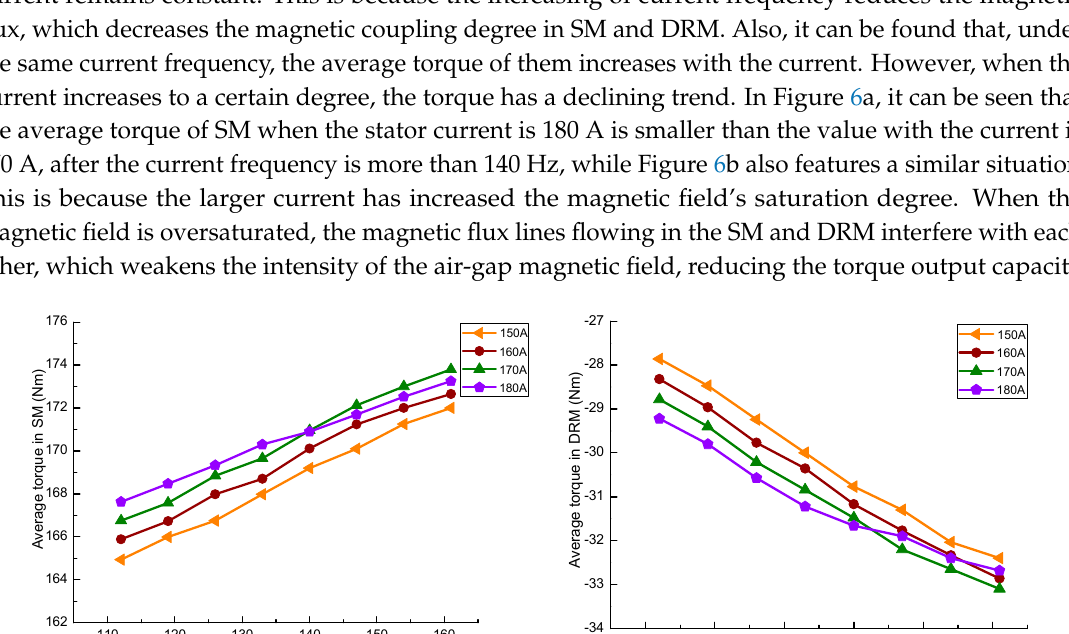
Figure 6. Variation of average torque curve in SM and DRM with winding current frequency: ( a ) SM; ( b ) DRM.